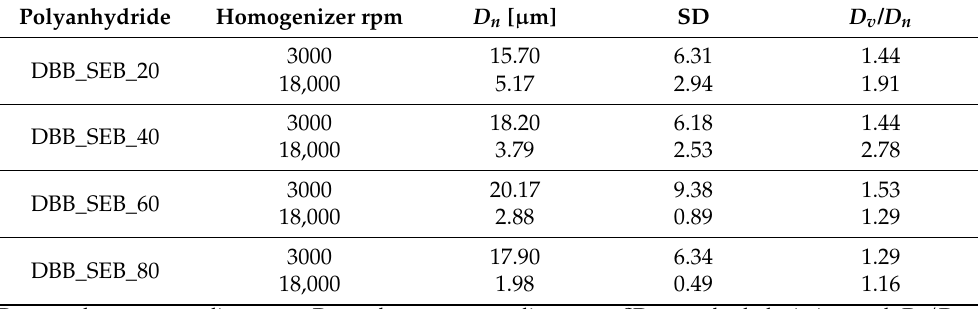
Table 5. Size and size distribution of blank microspheres calculated from optical microscope.